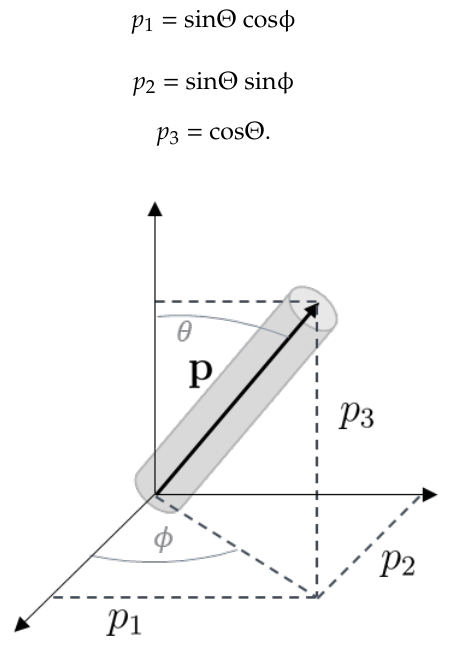
Figure 1. Definition of a single unit fiber in space .